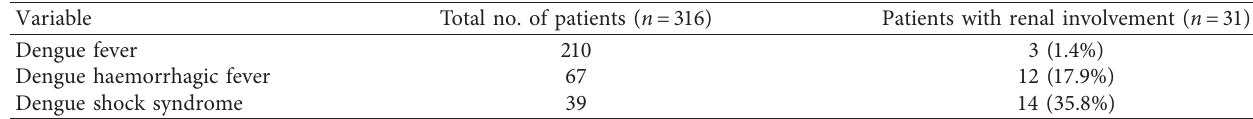
Table 3: Comparison of laboratory characteristics among dengue patients with and without renal involvement. Parameters